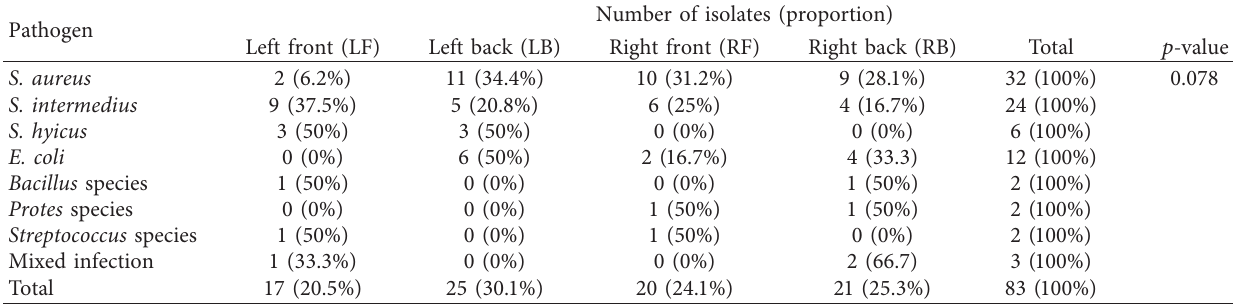
Table 2: Proportion/infection rate of clinical mastitis at the teat level.